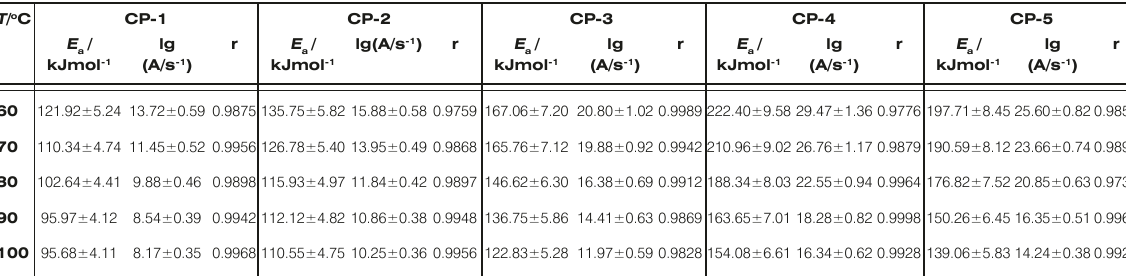
Table 2. Non-isothermal kinetic parameters of the composite propellants at different temperatures.